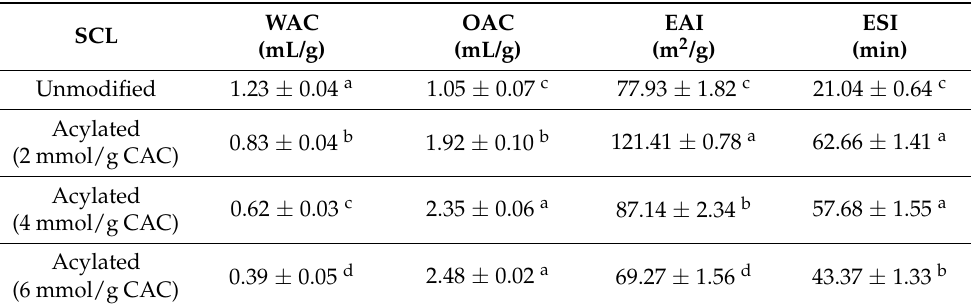
Table 1. Effect of secalin (SCL) lipophilization with increasing capric acid chloride (CAC) on protein water (WAC) and oil absorption capacities (OAC) and on its emulsifying activity (EAI) and emulsion stability index (ESI) *.